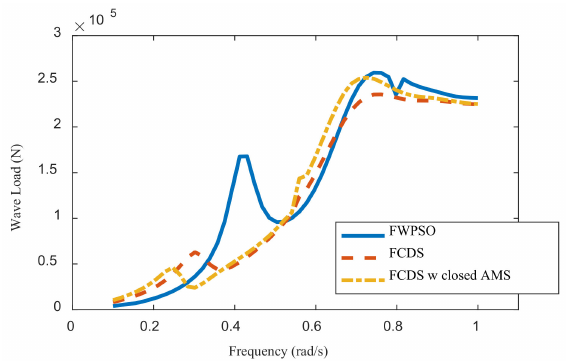
Figure 7. Second-order wave load transfer functions of